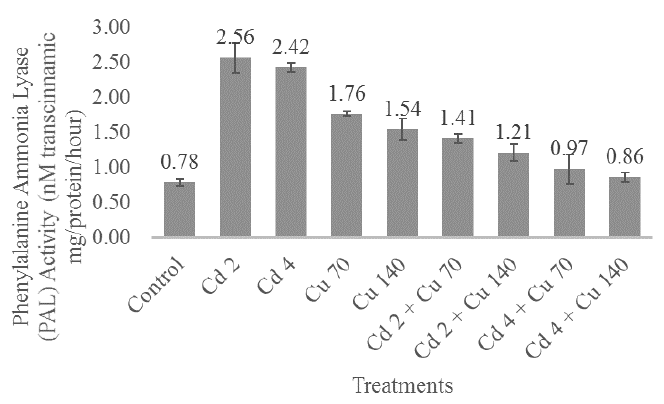
Figure 1. The impact of cadmium and copper on PAL activity of G. procumbens . Bars represents standard error of differences between the means. N = 15. Cd 2 = cadmium 2 mg/L; Cd 4 = cadmium 4 mg/L; Cu 70= copper 70 mg/L; Cu 140 = copper 140 mg/L; Cd 2 + Cu 70 = cadmium 2 mg/L + Copper 70 mg/L; Cd 2 + Cu 140 = cadmium 2 mg/L + copper 140 mg/L; Cd 4 + Cu 70 = cadmium 4 mg/L + copper 70 mg/L; Cd 4 + Cu 140 = cadmium 4 mg/L + copper 140 mg/L.